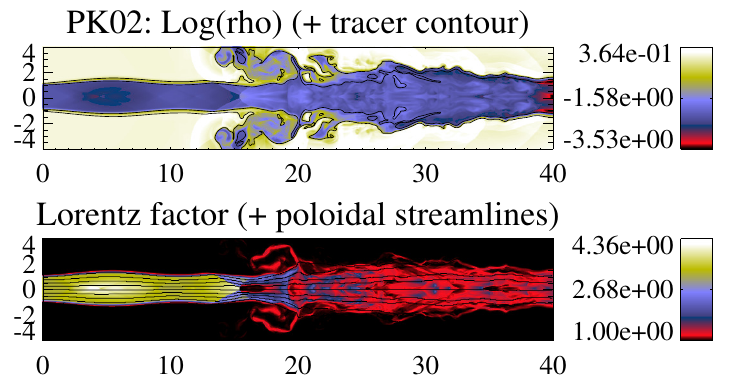
Figure 7. Structure of the Poynting-flux-dominated jet PK02 with a thinner shear layer. Top panel : distribution of rest-mass density with two contour lines for jet mass fraction values 0.005 and 0.995. Bottom panel : flow Lorentz factor distribution with poloidal flow lines